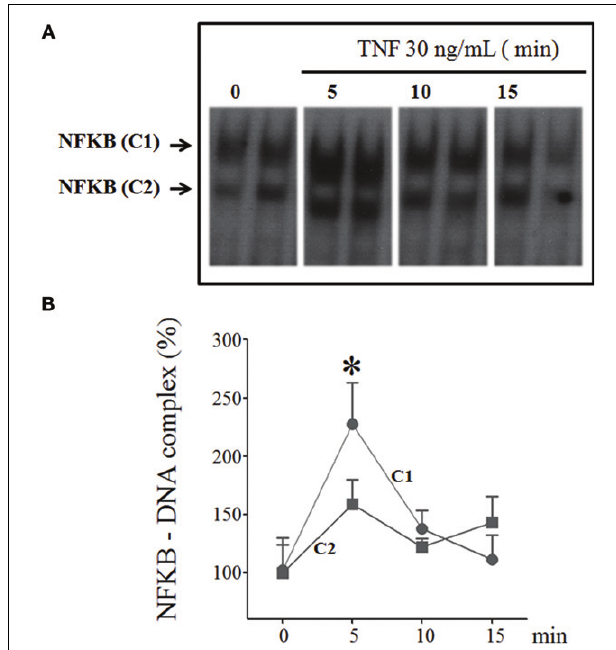
FIGURE 5 |Time-course ofTNF-induced NFKB translocation in cultured rat pineal glands. (A) Representative autoradiogram from EMSA, revealing the presence of two NFKB–DNA complexes, C1, and C2.The rat pineal glands were stimulated or not stimulated withTNF (30ng/mL) for 5, 10, or 15min. (B) Densitometric quantification of the two complexes, C1 and C2 in (A) , represented as a percentage of the normalized data from control glands (set as 100%), demonstrating thatTNF activates the nuclear translocation of NFKB after 5min incubation. Data are shown as the mean ± SEM; n = 3–4 glands per point. * p < 0.05 vs. noTNF.